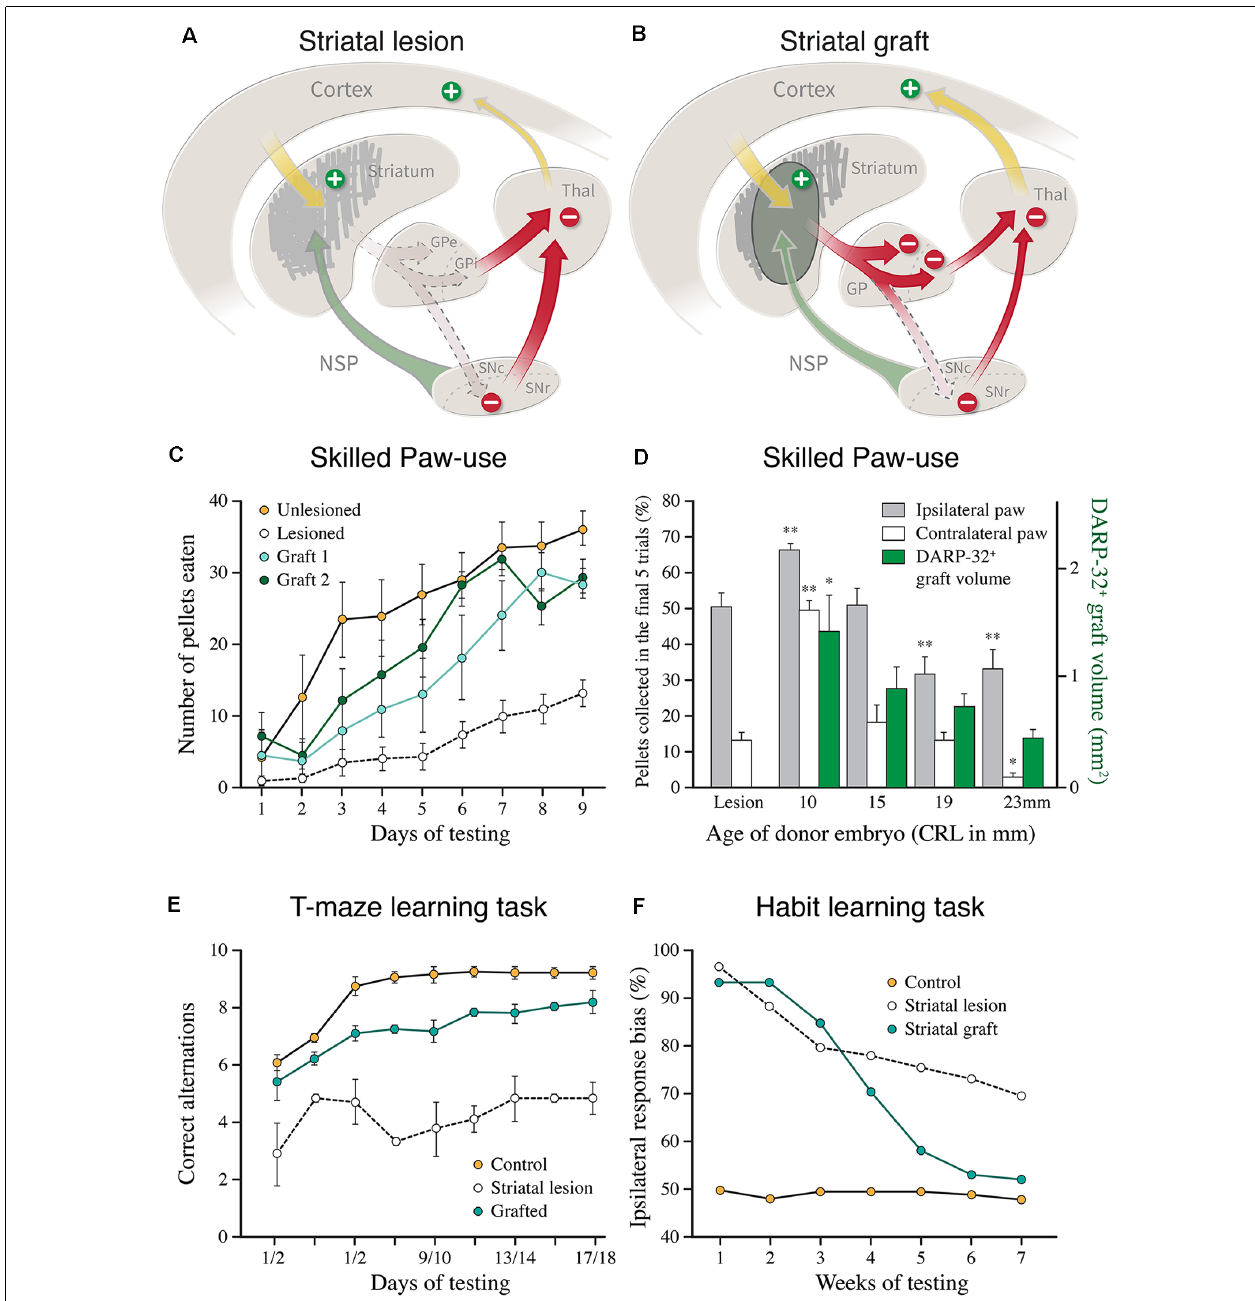
FIGURE 3 | (A,B) Cartoons illustrating the disinhibitory effect of the excitotoxic striatal lesion on the downstream targets, globus pallidus (GPe and GPi), and substantia nigra pars reticulata (SNc), and the reversal of this effect induced by the striatal graft. (C) Recovery of skilled motor performance is the paw reaching test, as seen in two groups of lesioned and grafted rats, using grafts derived from the lateral ganglionic eminence (LGE) only (modified from Nakao et al., 1996). (D) Recovery of the use of the paw contralateral to the lesion and grafted side (open bars) is well correlated to the volume of the DARPP-32+ portion of the fetal GE grafts, obtained from the whole GE at different donor ages (green bars; modified from Fricker et al., 1997). (E) Graft-induced recovery in the performance of delayed alternation in the classic T-maze task in rats with bilateral striatal lesions and transplants (modified from Isacson et al., 1986). (F) Graft-induced recovery of habit learning in rats with unilateral striatal lesions and transplants. In this test, the grafted animals had to relearn the task over a similar period, 6–8 weeks, as seen in intact rats learning the same task for the first time (modified from Brasted et al., 1999). ∗ p < 0.05, ∗∗ p < 0.01.